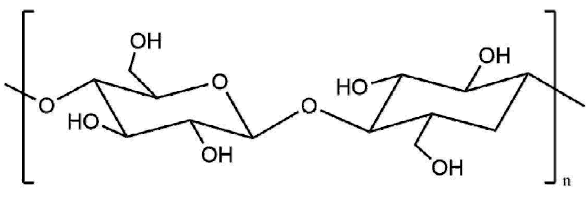
Figure 2. Chemical structure of cellulose.